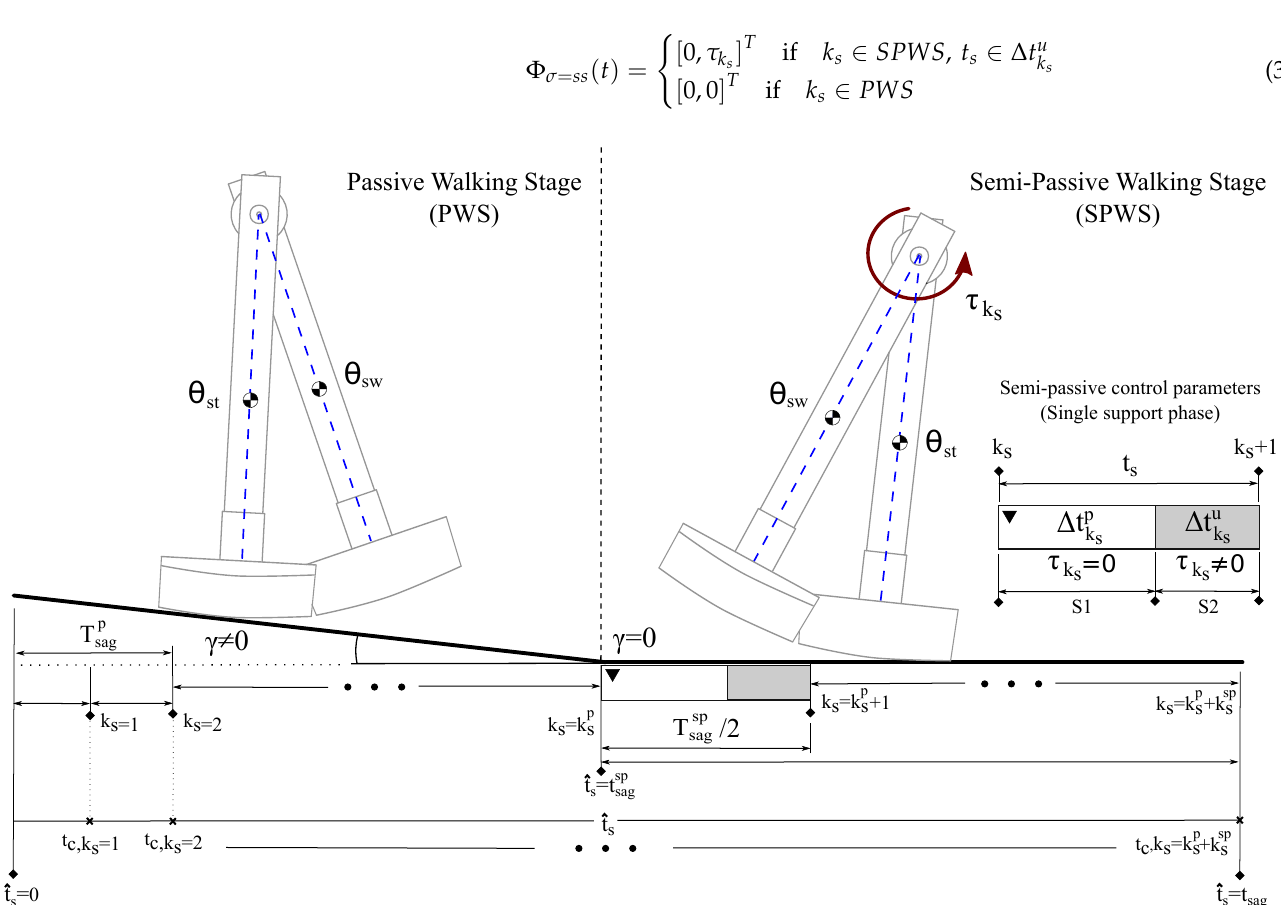
Figure 3. Walking stages of